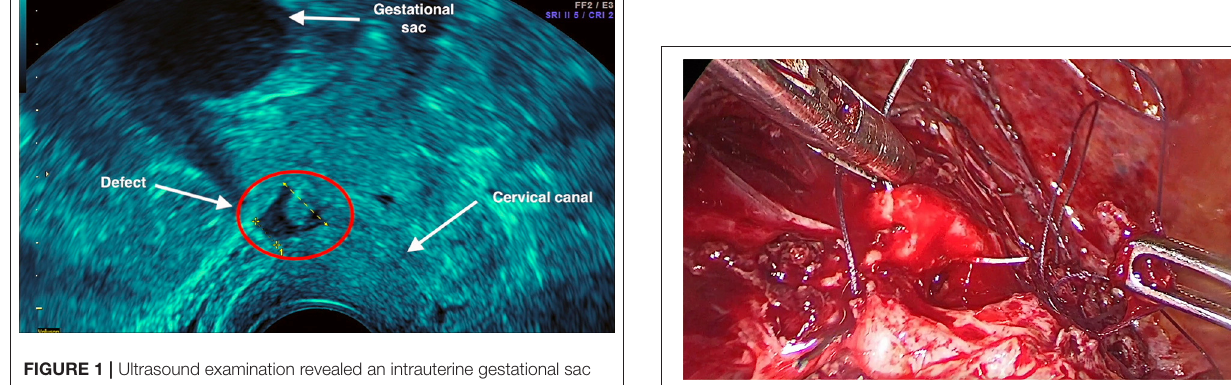
FIGURE 3 | The intraoperative aspect: two-layer suture of the